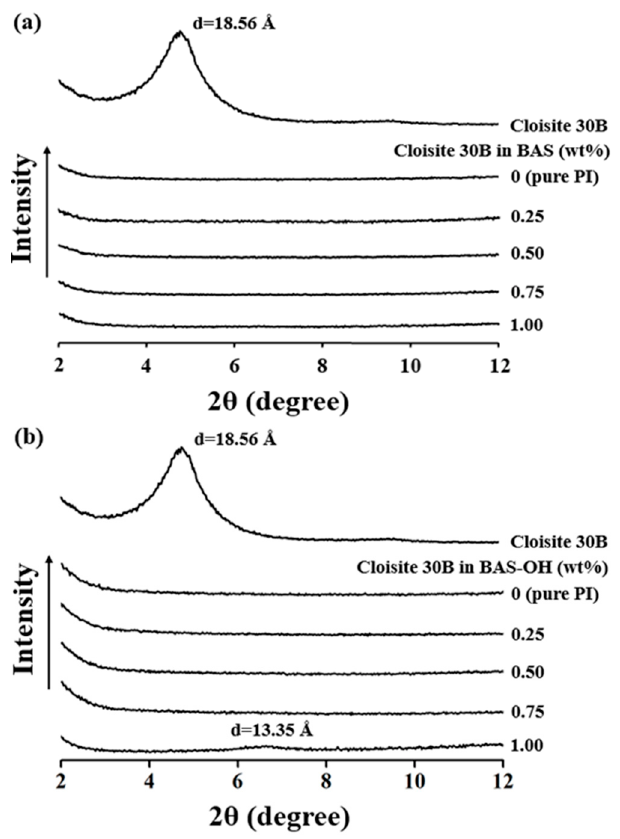
Figure 4. Wide angle X-ray patterns of PI hybrid films with various organoclay. contents: ( a ) BAS and ( b ) BAS-OH.